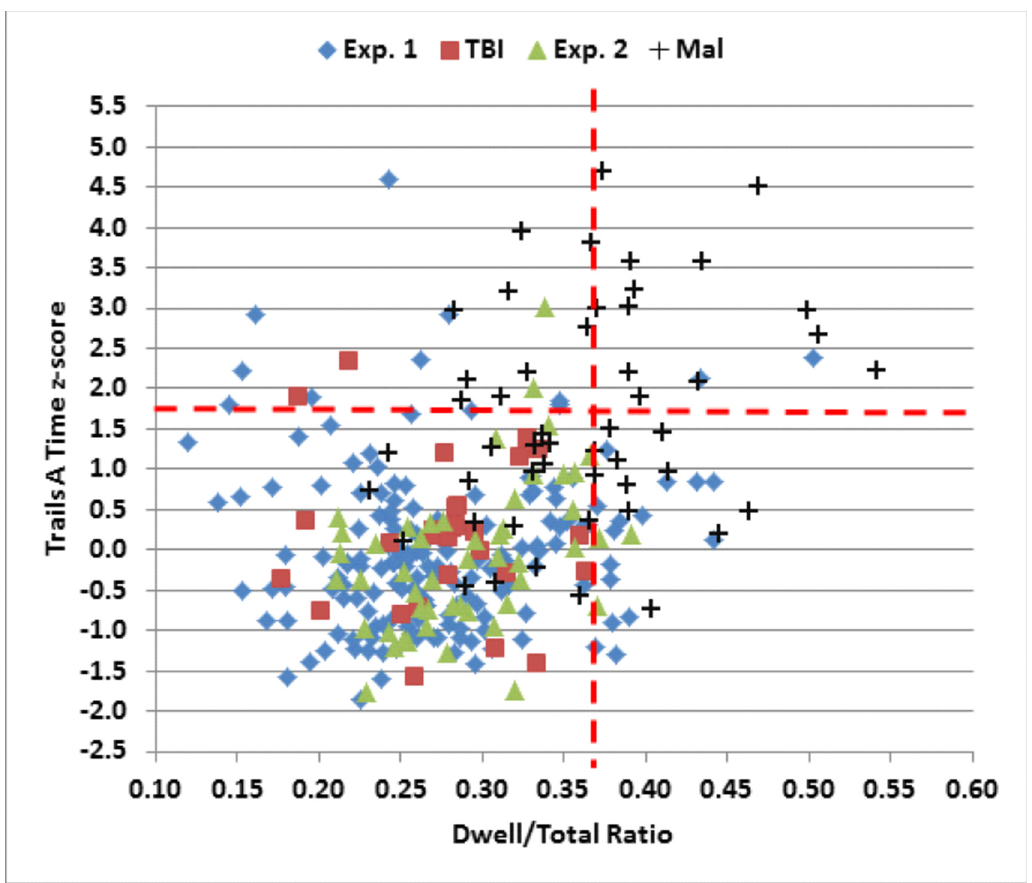
Fig 7. C-TMT-A completion-time z-scores as a function of the dwell-time/total time ratios. The dashed horizontal line shows the p < 0.05 abnormality threshold for completion time. The dashed vertical line shows the p < 0.10 threshold for the dwell-time/total-time ratio. C-TMT-B metrics showed similarly high test-retest reliability for total-time z-scores (ICC = 0.85) and velocity z-scores (ICC = 0.90). Other metrics also showed significant test-re- test correlations, including dwell-time (ICC = 0.76), move-time (ICC = 0.75), and dwell-time/ total-time ratios (ICC = 0.74). However, lower reliability was seen for circuitousness (ICC = 0.65), and particularly for error time (ICC = 0.33). Intraclass correlation coefficients for difference measures between the C-TMT-B and C-TMT-A were reduced, e.g., for total-time z- scores (ICC = 0.56) and velocity (ICC = 0.48). The average within-subject standard deviation in completion times for the C-TMT-B was 5.34 s. Table 6. Performance improved on successive test sessions (Experiment 2b and 2c), as shown in Table 4. On the C-TMT-A, total time was reduced by 12% (p < 0.001) between Experiments 2a and 2b, due to reduced dwell- and move-times, reduced circuitousness, and increased veloc- ity. No significant differences in completion time were seen between Experiments 2b and 2c. Mean z-score improvements amounted to -0.52 for completion time and -0.38 for velocity when Experiment 2a and Experiment 2c were compared. Performance improvements were somewhat larger on the C-TMT-B, reducing completion times by 20% overall, with perfor- mance improvements again concentrated between Experiments 2a and 2b, and overall z-score